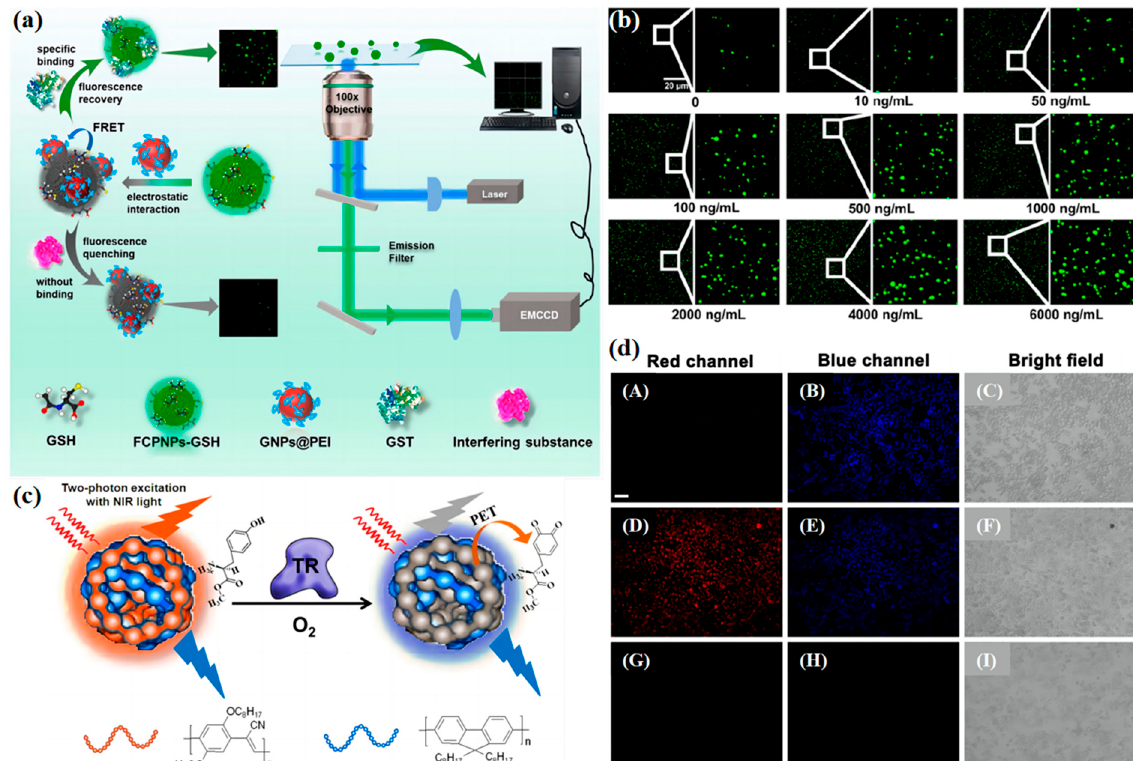
Figure 4. ( a ) Schematic Diagram of the Light Path for Single-Particle Imaging and the Principle of SPE Assay for GST Detection. Adapted with permission from [53] ( b ) Fluorescence images of FCPNPs-GSH on the glass slide surface at various concentrations of GST. Adapted with permission from [53] ( c ) Schematic Illustration of Tyr-OMe Functionalized Pdots for Fluorescence Sensing of Tyrosinase. Adapted with permission from [60] ( d ) ( A – C ) Two-photon fluorescence images of B16 cells labeled with Pdots@Tyr-OMe. ( D – F ) Two-photon fl uorescence images of Pdots@Tyr-OMe- stained B16 cells pretreated with tropolone (50 µM) for 10 min. ( G – I ) Two-photon fl uorescence im-ages of untreated control B16 cells. RPMI 1640 media supplemented with 10% fetal bovine serum is used for imaging experiments, and the concentration of Pdots@Tyr-OMe is 1.0 µg/mL. The scale bar represents 100 µm. Adapted with permission from [60].